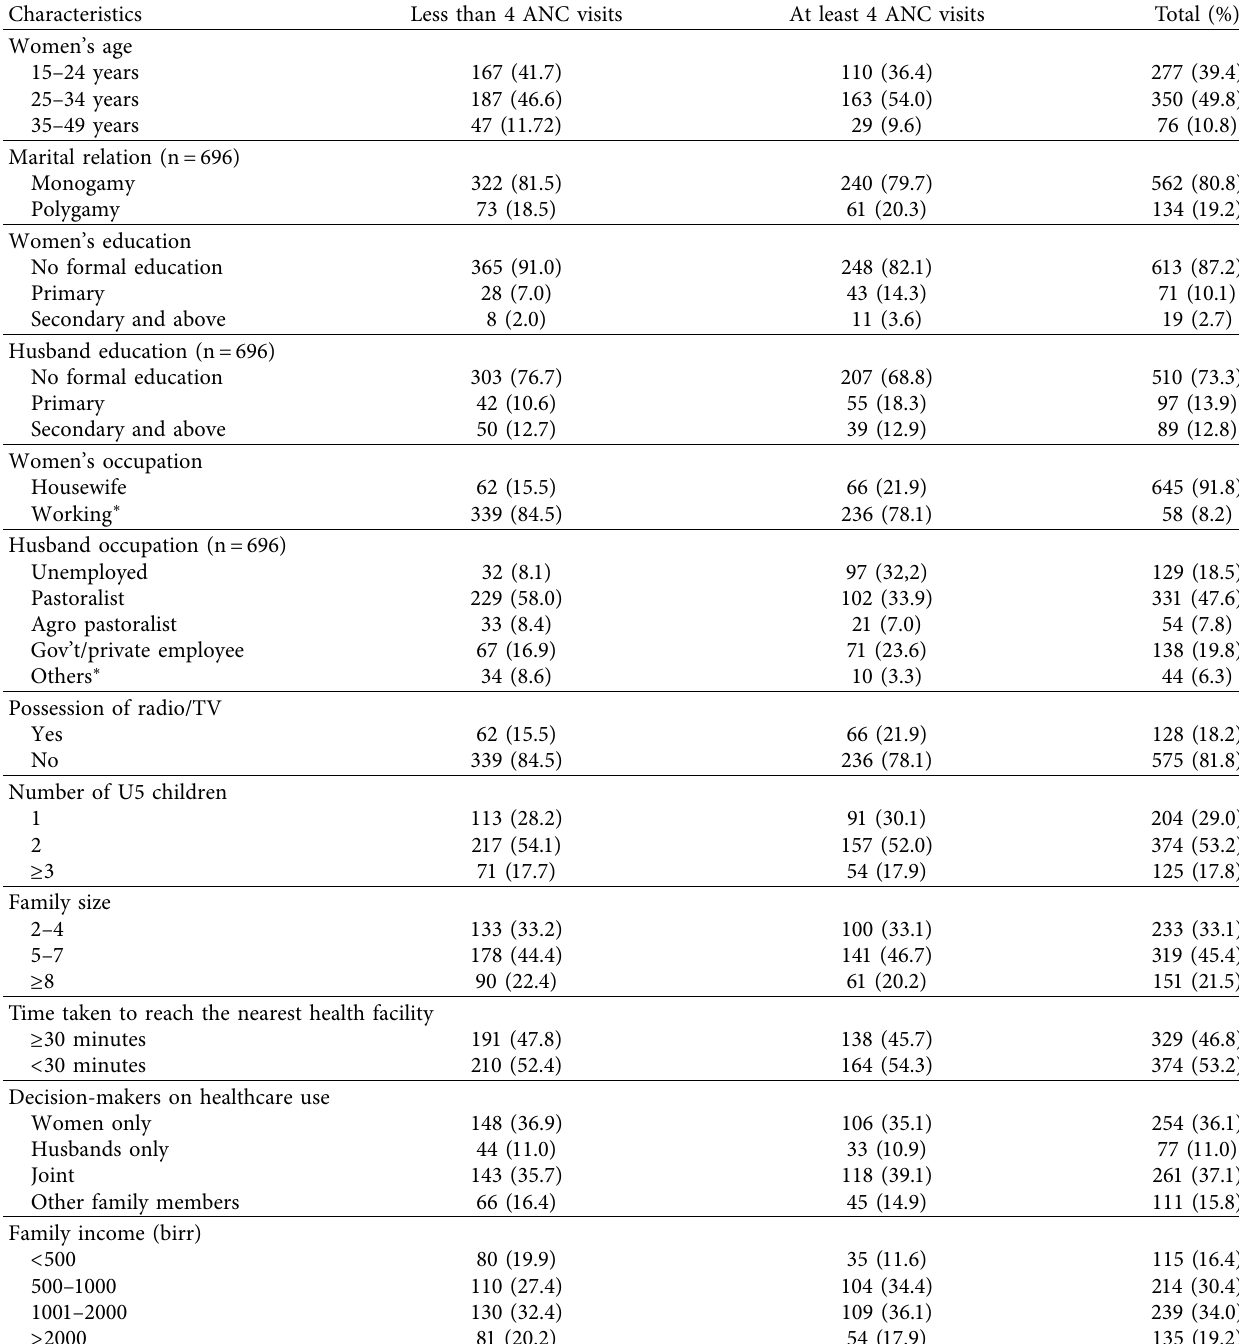
Table 1: Sociodemographic characteristics of women who gave birth in the past two years in the pastoral community, Northeast Ethiopia, 2020 ( n �